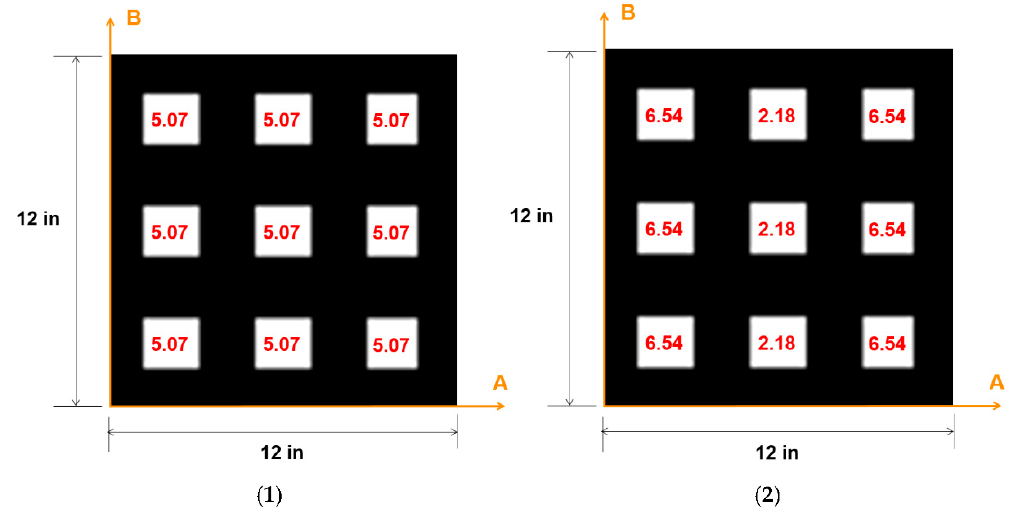
Figure 4. Tile flow velocity distortion—numbers in the white areas are the velocity magnitudes issued from the openings: ( 1 ) uniform case, ( 2 ) non ‐ uniform case.